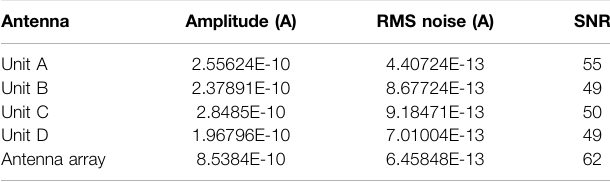
Frontiers in Physics |